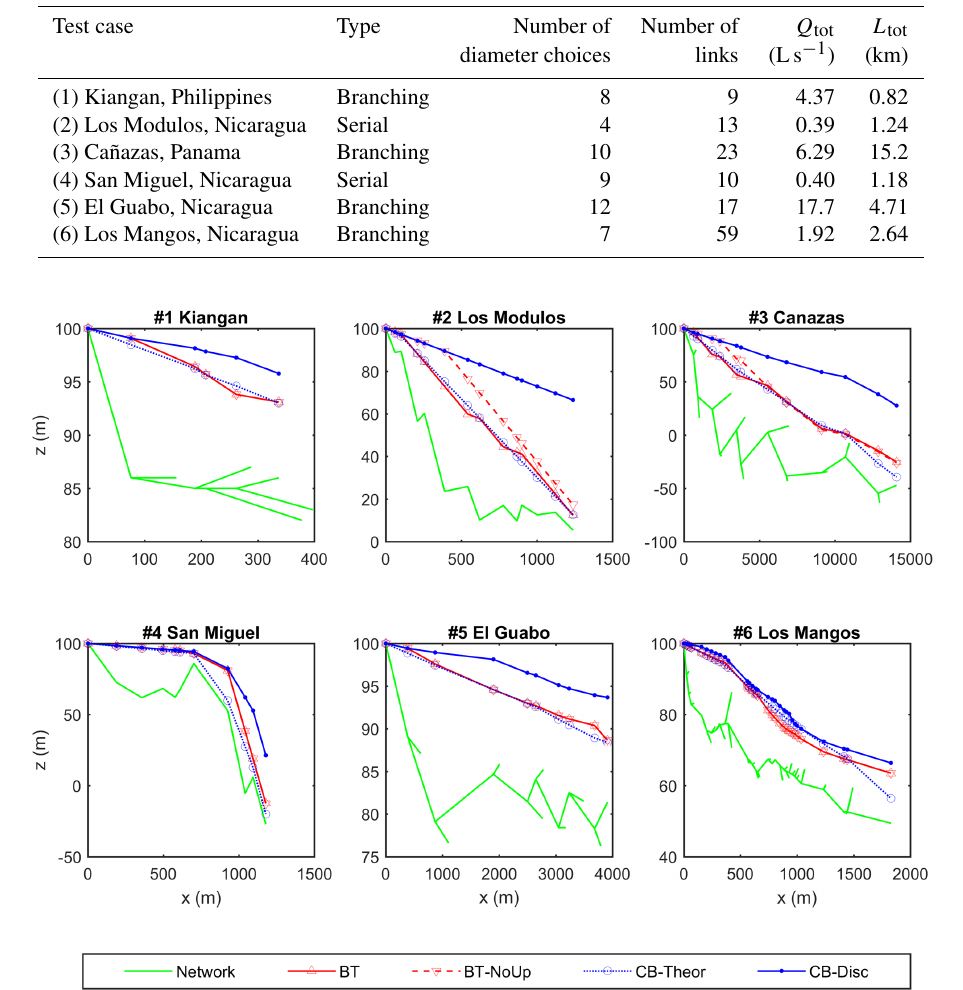
Figure 5. Network elevation ( z ) and hydraulic grade lines (HGLs) of algorithm solution for main distribution